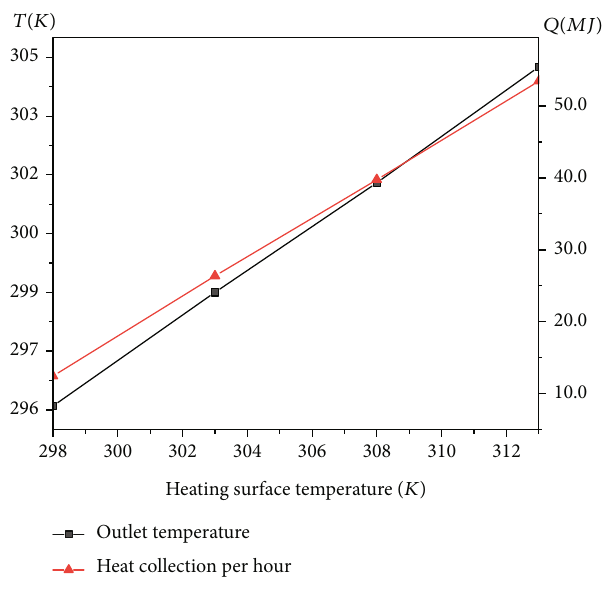
Figure 9: Outlet temperature and heat collection at di ff erent heating temperatures.